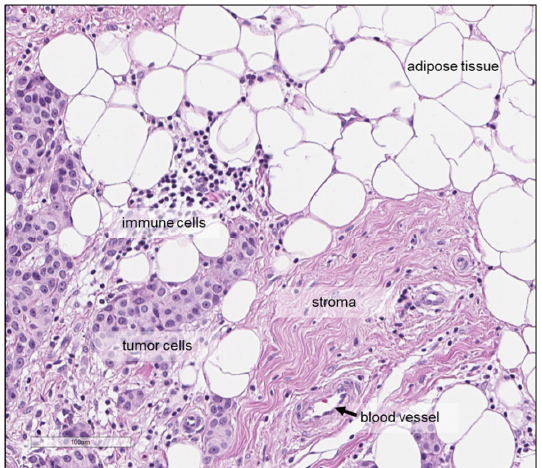
Figure 6. Haematoxylin-eosin staining showing the tumour tissue microenvironment of a breast carcinoma and different types of cells, including tumour cells, immune cells and adipocytes - as well as stroma and blood vessel. Scale bar: 100 μm.